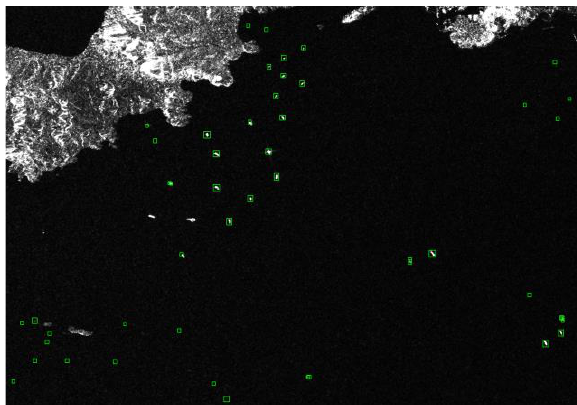
Figure 7. Detected ship targets in the 2D-PCA based fused result of the Envisat scenes, using a CFAR stencil of size